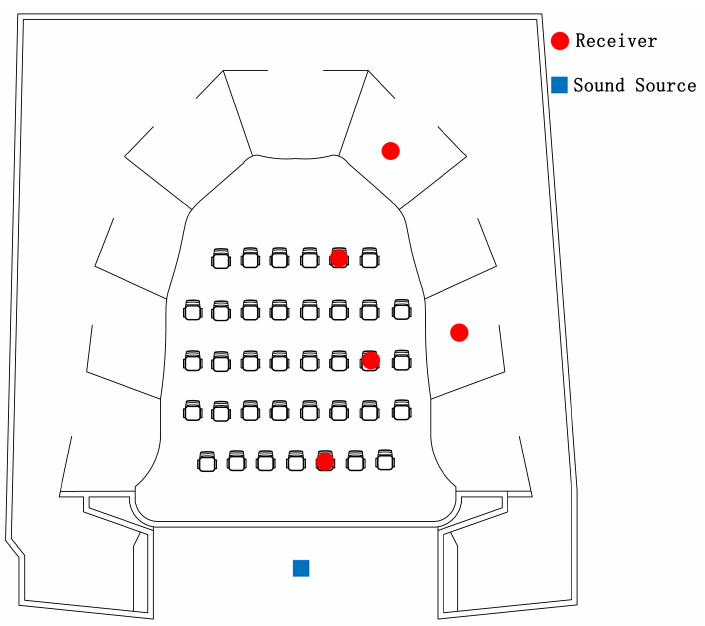
Figure 7. Scheme of the equipment location during the acoustic survey.